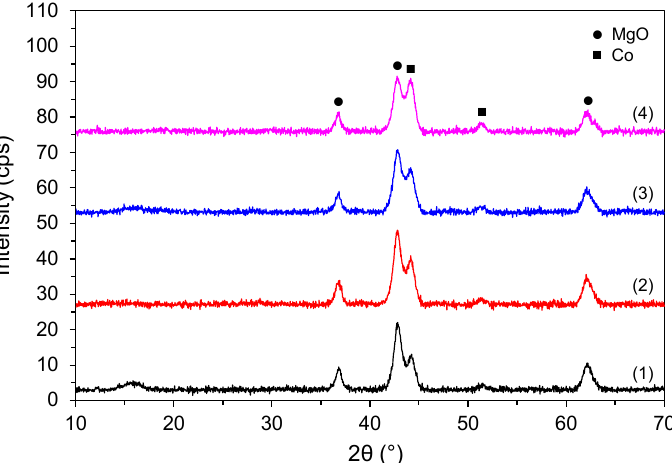
Figure 5. XRPD patterns of the Ba/Co/Mg-Al catalysts supported on hydrotalcite derived Mg-Al mixed oxides with various Mg/Al molar ratio: (1) 2Mg-Al, (2) 3Mg-Al, (3) 4Mg-Al, (4) 5Mg-Al.